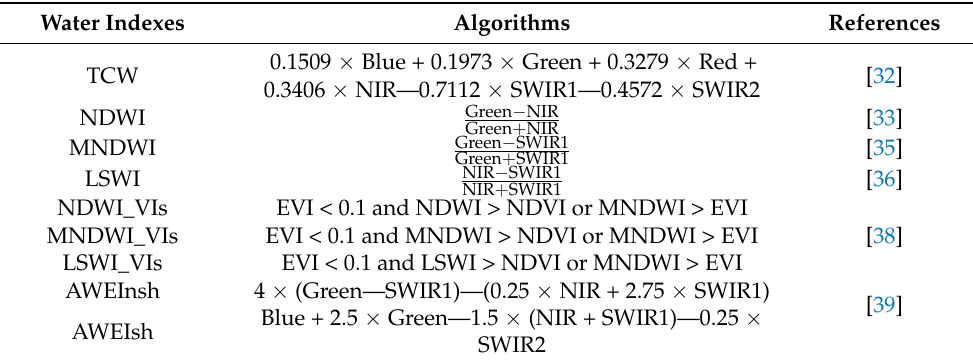
Table 1. Indexes commonly used for open surface water body